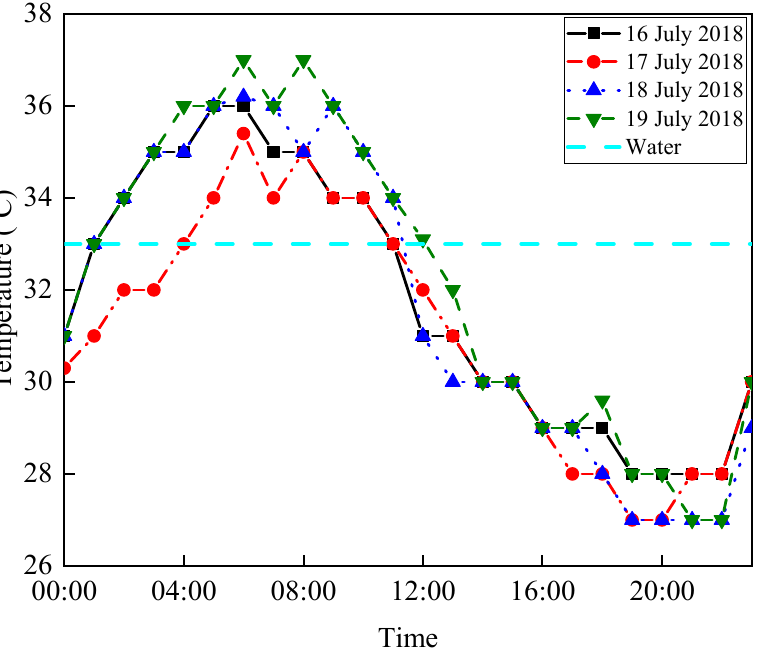
Figure 4. Hourly air temperature in summer (data from National Oceanic and Atmospheric Ad- ministration (NOAA), see: https://gis.ncdc.noaa.gov/maps/ncei/cdo/hourly).